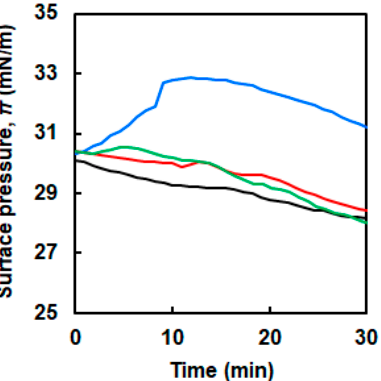
Figure 3. Changes in surface pressure of the DPPC membrane as a function of time in the absence of (black line) and presence of the EG n NFs; n = 6 (blue line), 12 (red line), 24 (green line).